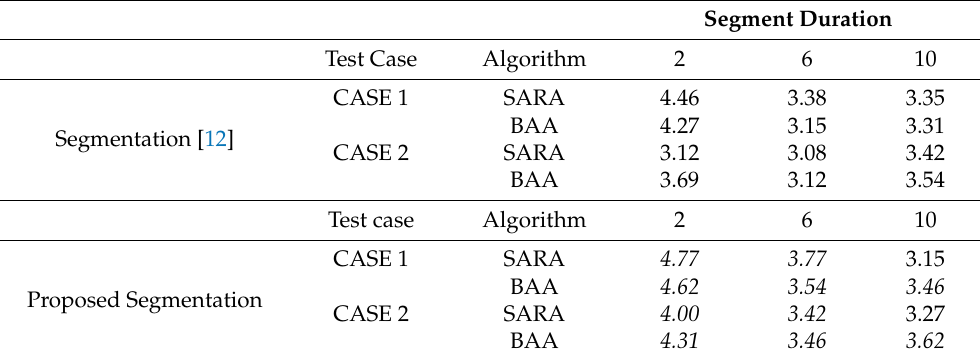
Table 9. MOS values obtained using the SARA and BBA adaptive streaming algorithms, two network test cases while BBB was segmented using the segmentation available in [12] and the proposed